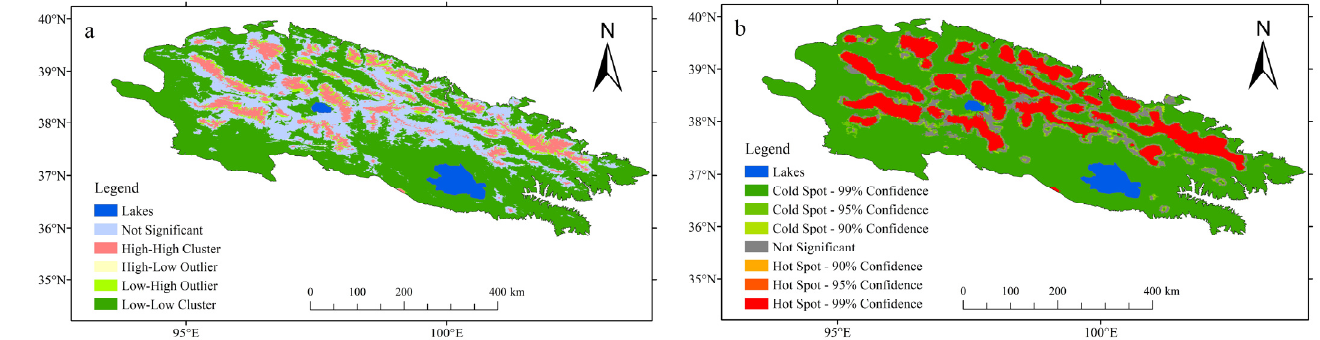
Figure 6. Anselin Local Moran’s I ( a ) and Getis-Ord Gi* ( b ) in autocorrelation analysis.